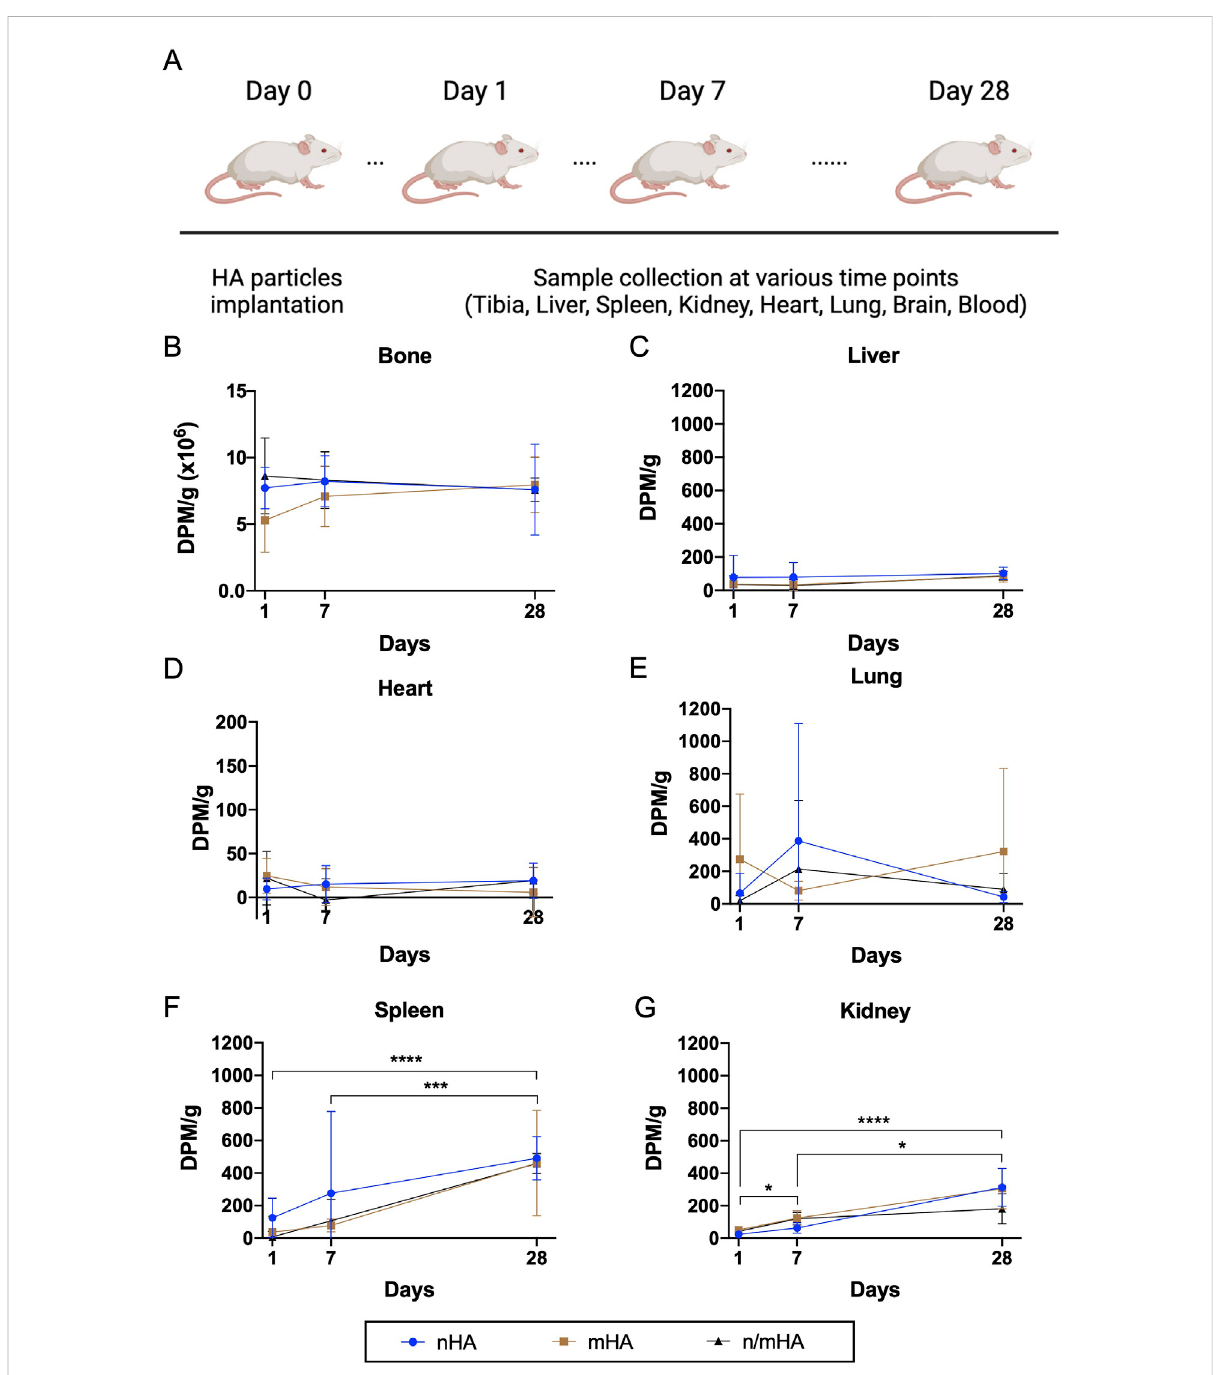
FIGURE 3 The time kinetics of HA particle (nHA, mHA and n/mHA) migration during the 28 days follow up period. (A) Shows follow-up timeline. (B – G) Shows the detected radioactivity of collected samples including the proximal tibia, liver, heart, lung, spleen and kidney, respectively. * indicates p